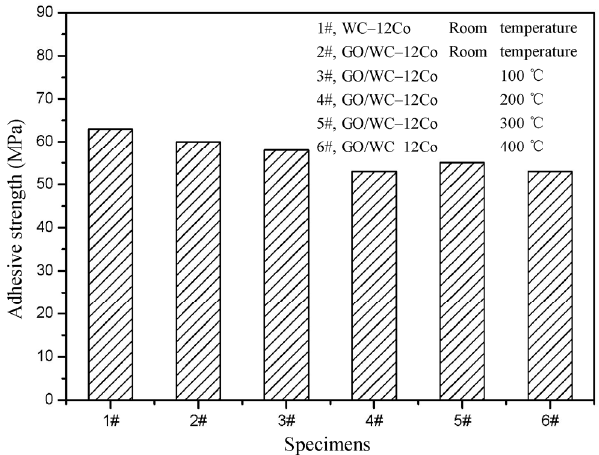
Fig. 9 Adhesive strength of the coatings prepared via different heat treatment processes.